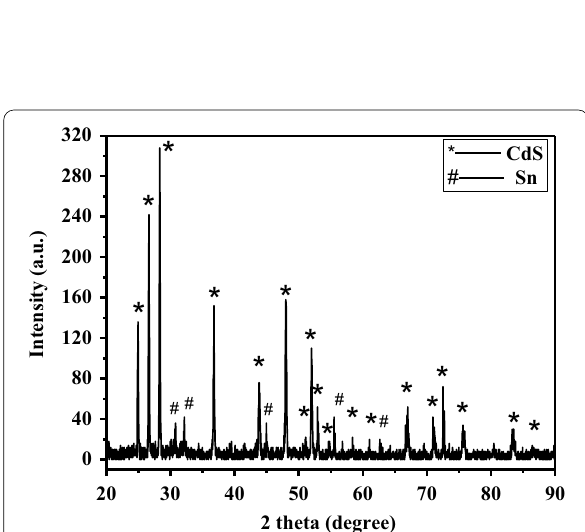
Fig. 2 X-ray diffraction patterns of Sn-doped CdS